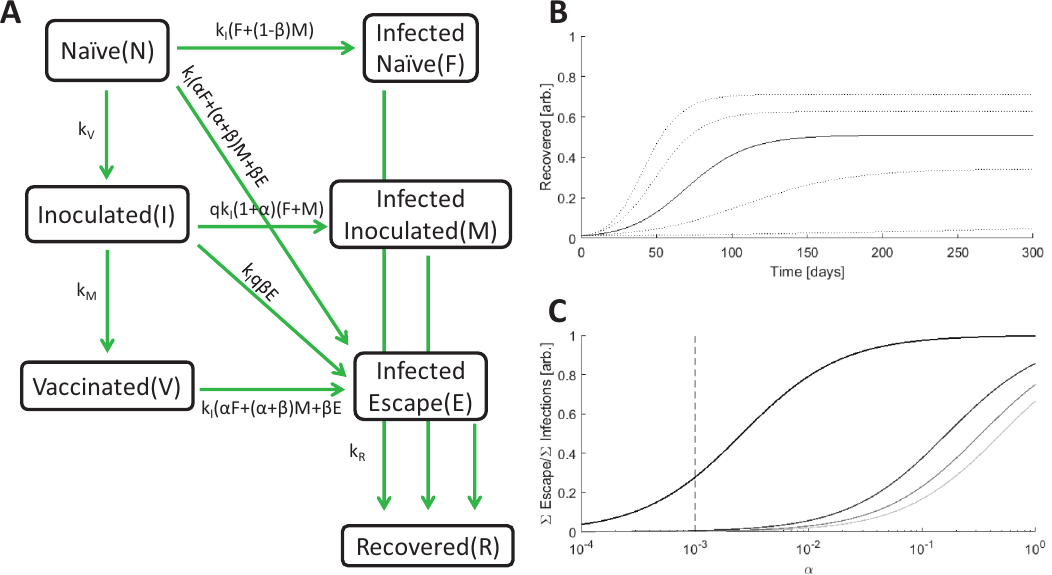
Figure 1. The model. A. Schematic of the seven-compartment model with three susceptible, three infected, and one recovered compartments. Rates (divided by the state at the beginning of the arrow) are displayed. B. Simulated epidemics for k I = [0.15,0.175,0.2 (solid line), 0.225,0.25], α = 0.001, β = 0.01. C. The ratio of cumulative escape infections to all cumulative infections for an epidemic over a range of α . β = [0.5,0.67,0.83,1], darker color indicates higher value, k I = 0.2. The dotted line specifies the benchmark value of α =